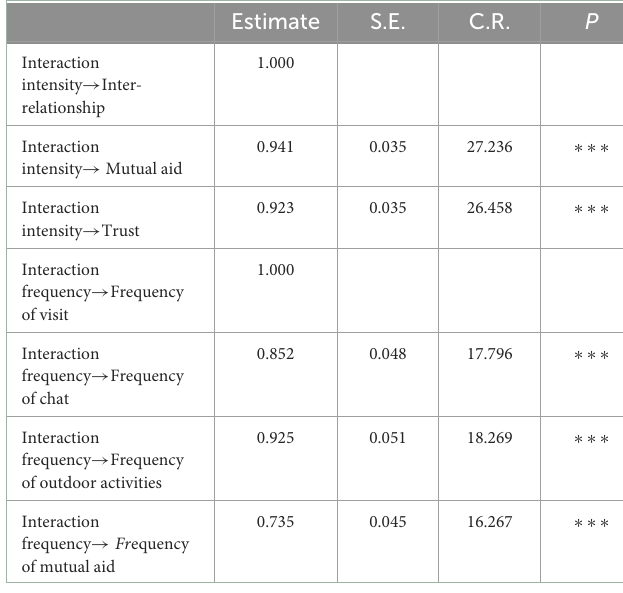
TABLE 2 Confirmatory factor analysis results.